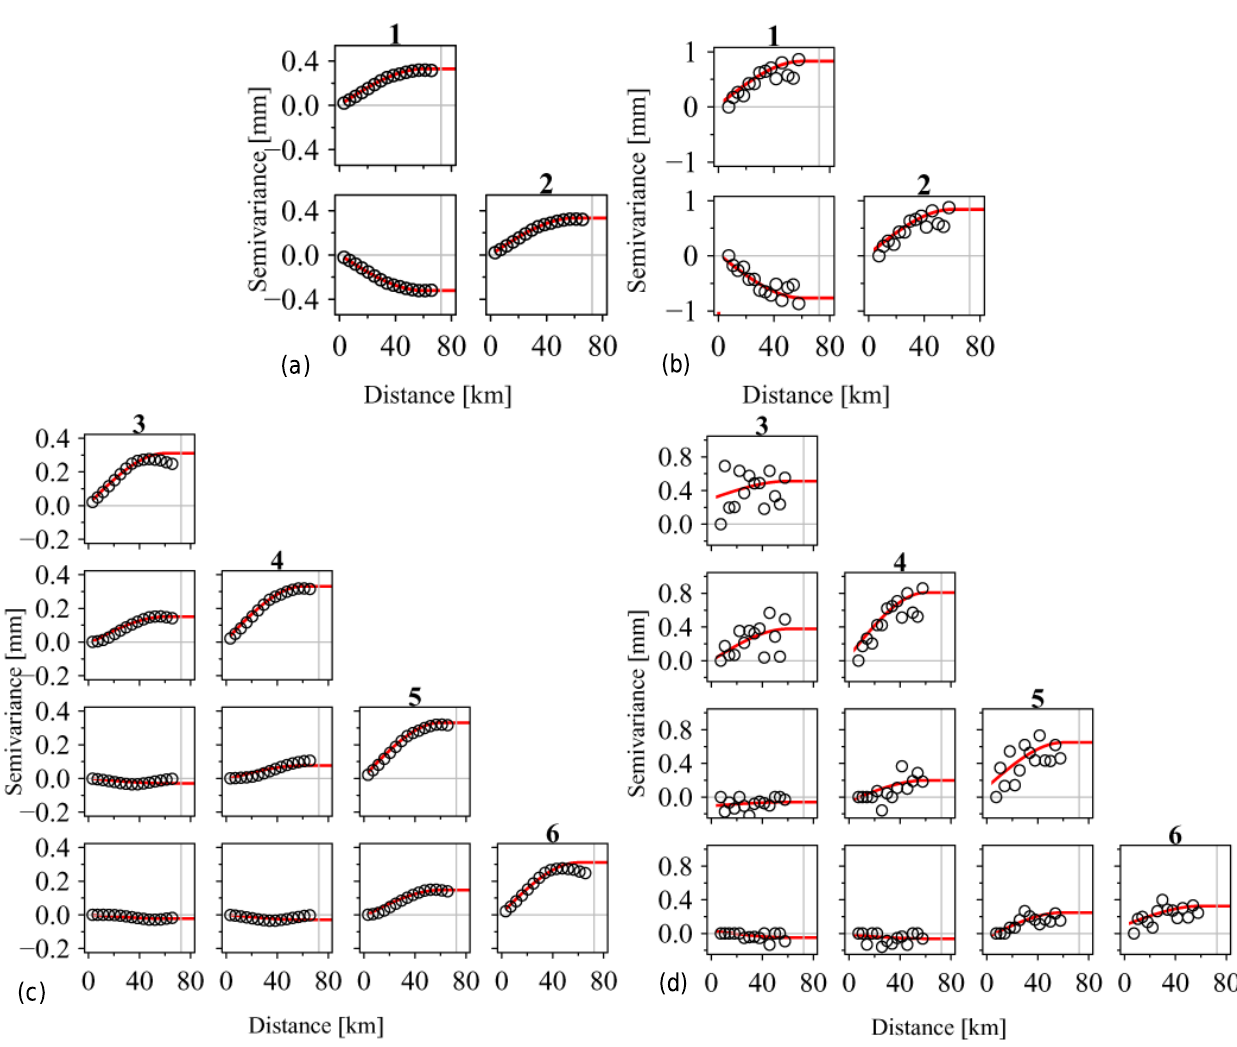
Fig. 8. Sensitivity analysis. Direct and cross-variograms for rainfall fields 1 and 2 (Fig. 7) derived from all grid points (a) and only the rain gauge grid points (b) . Direct and cross-variograms for rainfall fields 3–6 (Fig. 7) derived from all the grid points (c) and only the rain gauge grid points (d) . Grey vertical line shows the range corresponding to twice the diameter of the rainfall